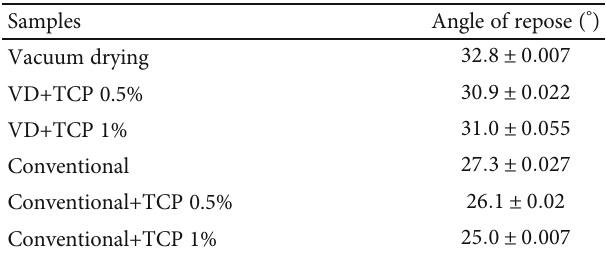
Figure 8: Hygroscopicity rate of coconut sugar powder produced by traditional and vacuum drying methods. Table 3: Angle of repose with the addition of